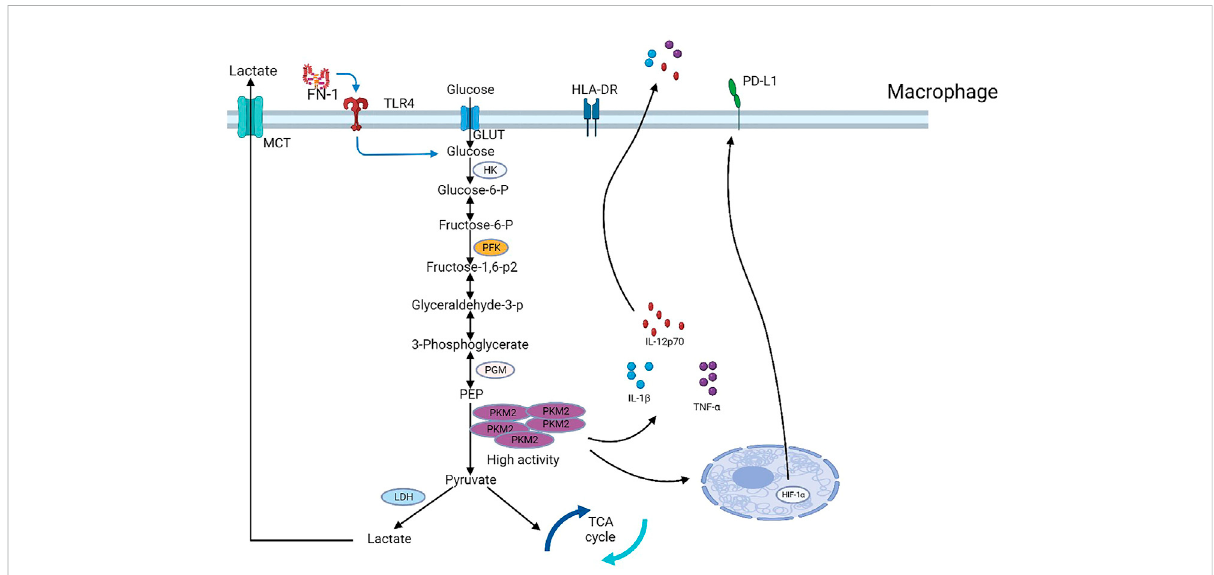
FIGURE 3 Major rate-limiting enzymes, metabolic enzymes, and transporters in the glycolytic pathway. PKM2, a key glycolytic enzyme regulated by fi bronectin 1 (FN-1) secreted by hepatocellular carcinoma cells, controls PD-L1 expression in macrophages in a HIF-1 α -dependent